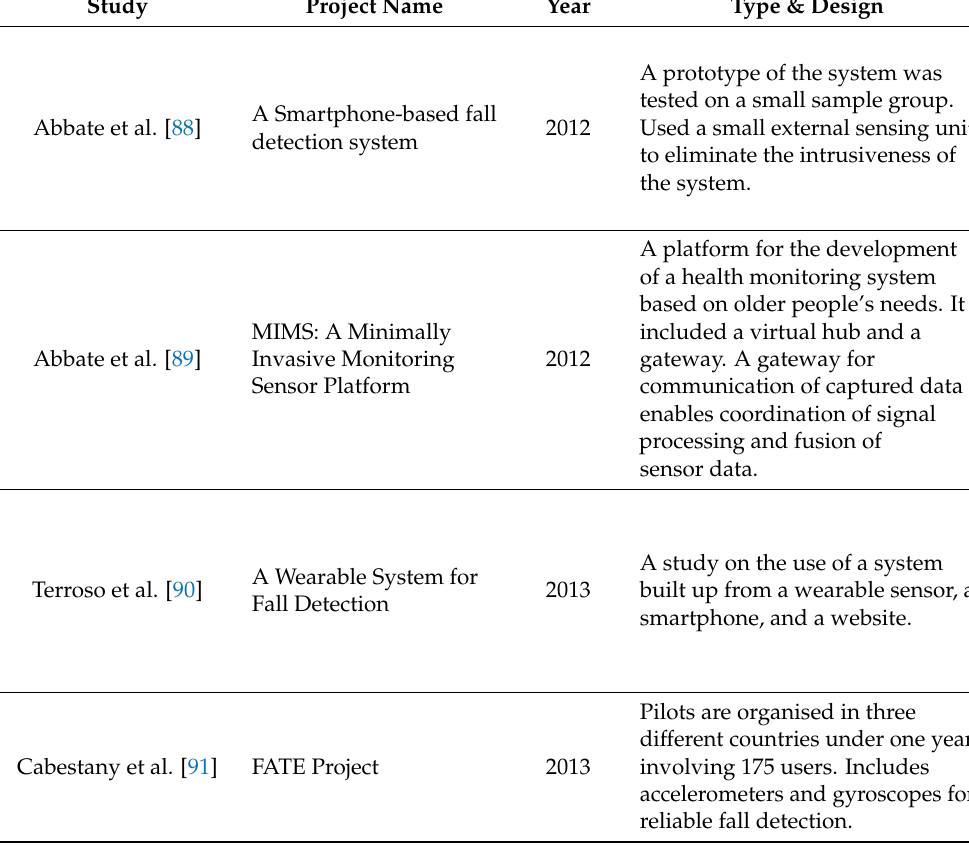
Table 8. ICT solutions for fall detection systems for assistive living of older